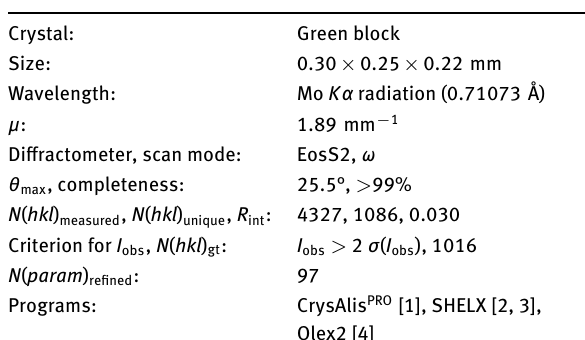
Table 1: Data collection and handling.